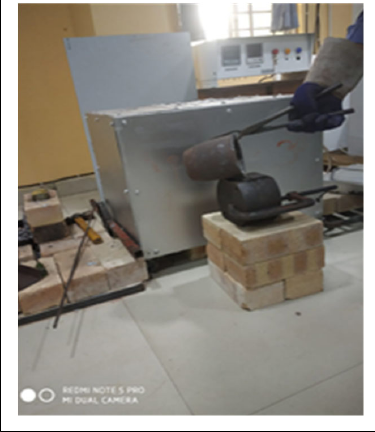
Fig. 1. Stirring of molten metal mixture Fig. 2. Pouring the molten metal into the die